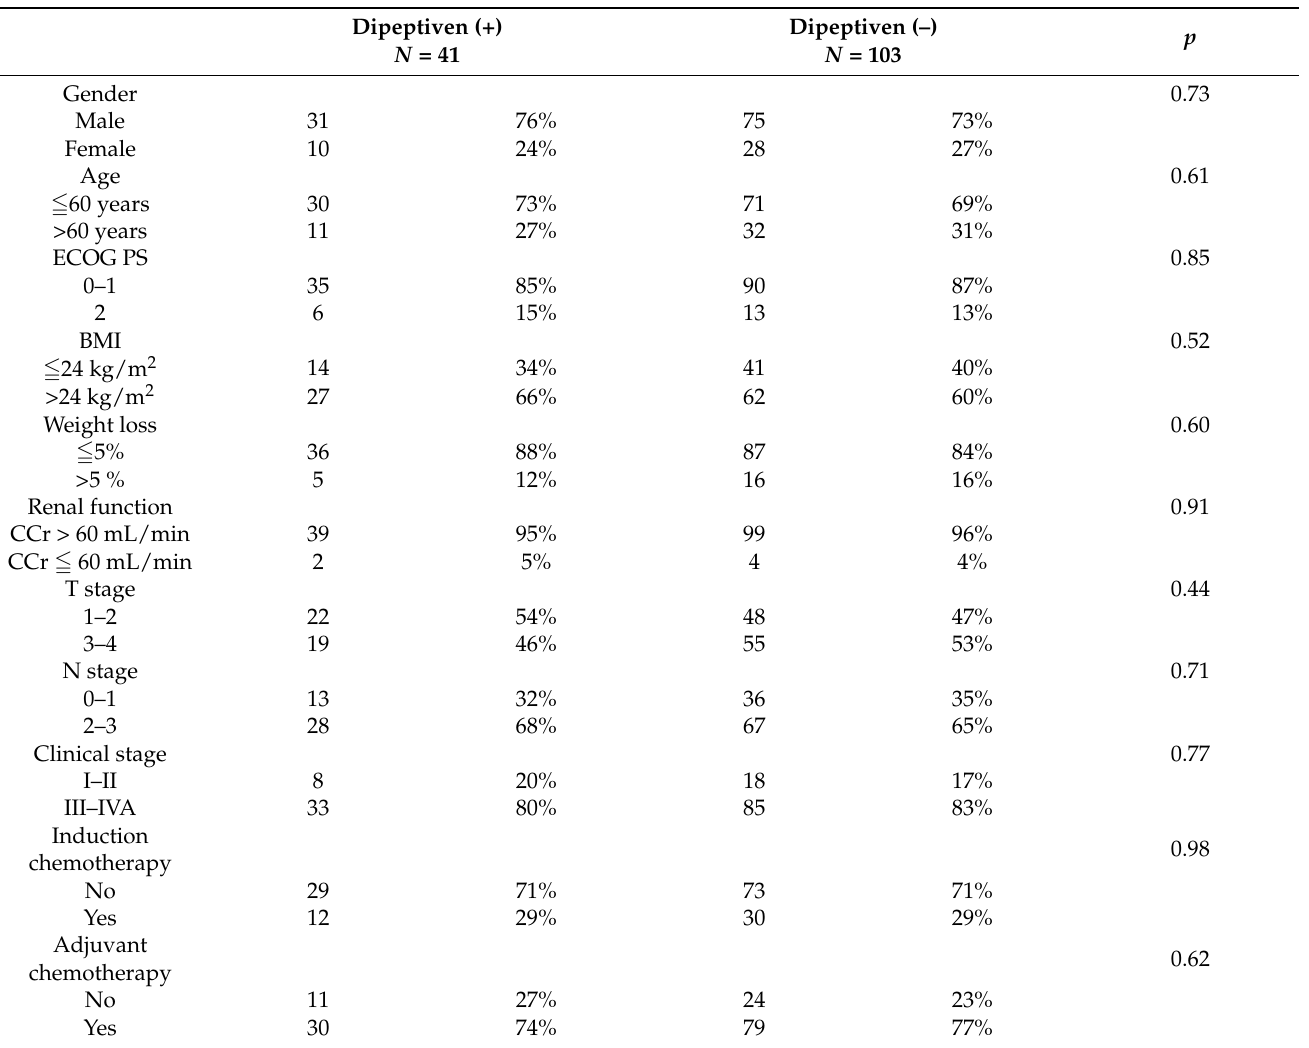
Table 1. Baseline clinical characteristics of 144 patients with nasopharyngeal carcinoma, stratified by